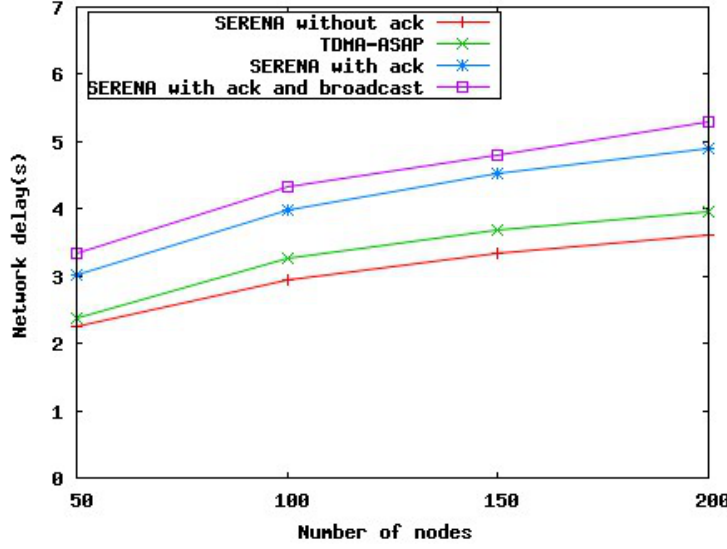
Figure 15. Network delays in a